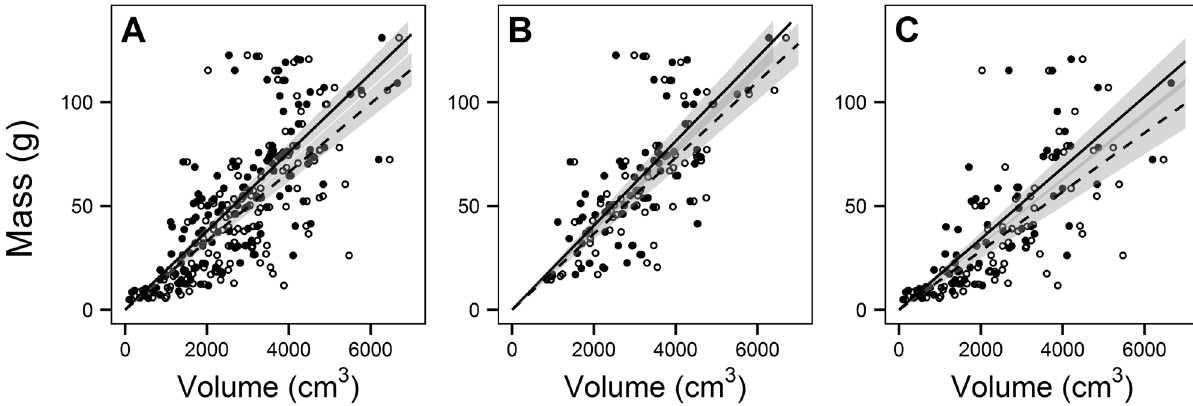
Figure 1. Biomass-volume relations using multiple methods. Shown are the ocular cover method (filled circles and solid lines) and the point count method (open circles and dotted lines), for all sample types combined (Fig. 1A), multi-taxa samples (Fig. 1B), and single-taxon samples (Fig. 1C). Lines indicate fitted model slopes (see Table 2 for estimates), while grey polygons indicate 95% confidence intervals.